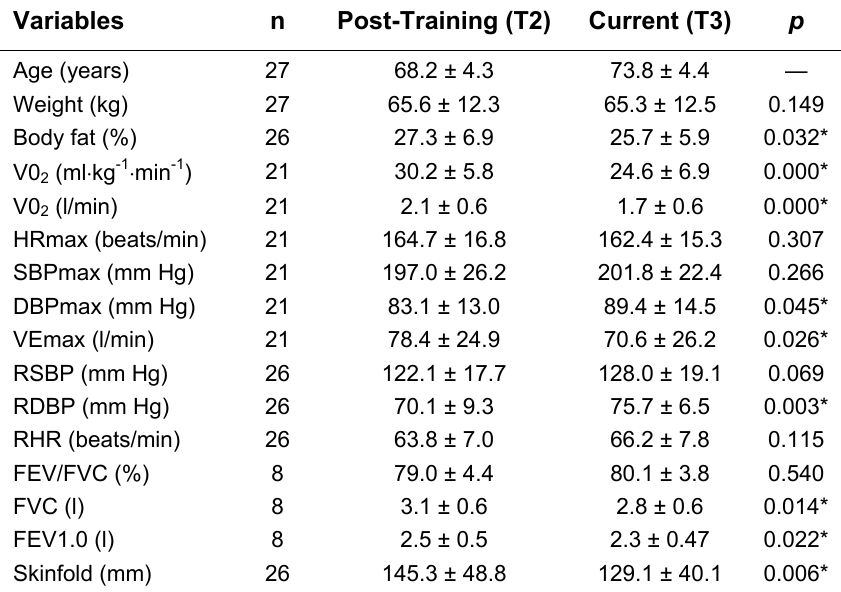
Post-Training and Current Measurements for Moderately Active Subjects